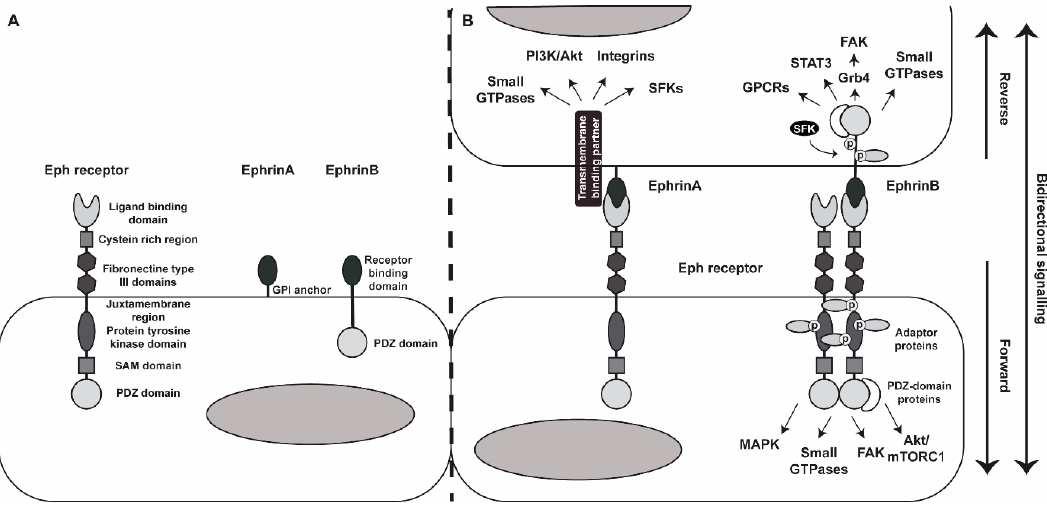
Figure 1. Eph/Ephrin structure and signaling ( A ) general structure of the Eph receptors, ephrinA ligands and ephrinB ligands. ( B) Eph/Ephrin bidirectional signaling and some of its signaling ligands and ephrinB ligands. ( B ) Eph / Ephrin bidirectional signaling and some of its signaling pathways. SAM = sterile alpha motif, GPI = glycosylphosphatidylinositol, PI3K = phosphoinositide 3-